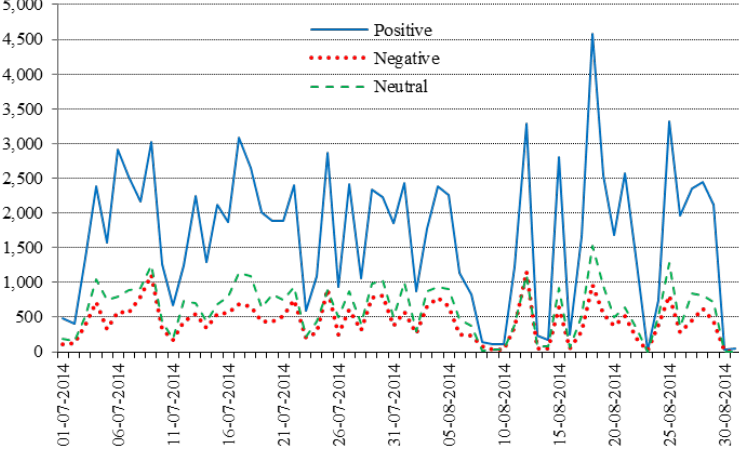
Figure 3. Tweet polarity on a day-per-day basis.